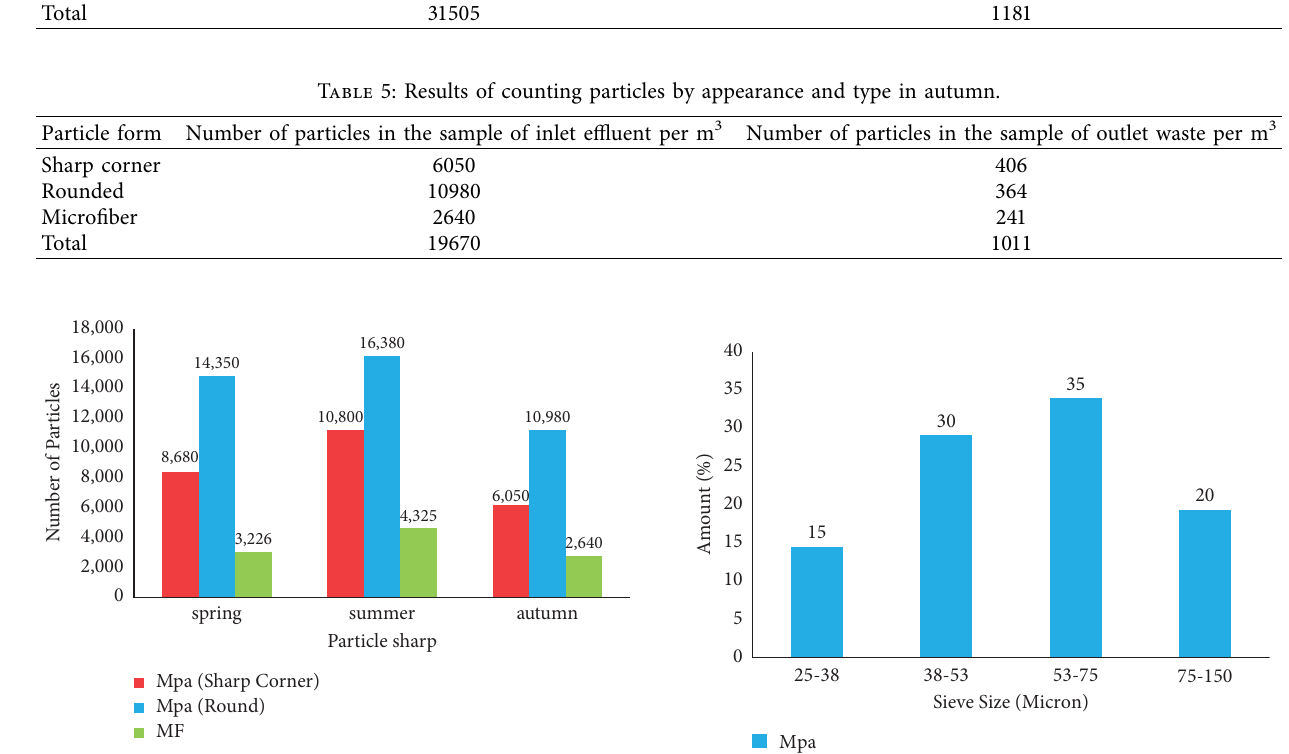
Figure 7: Comparison of microplastic particles abundance in the inlet efuent for diferent seasons.